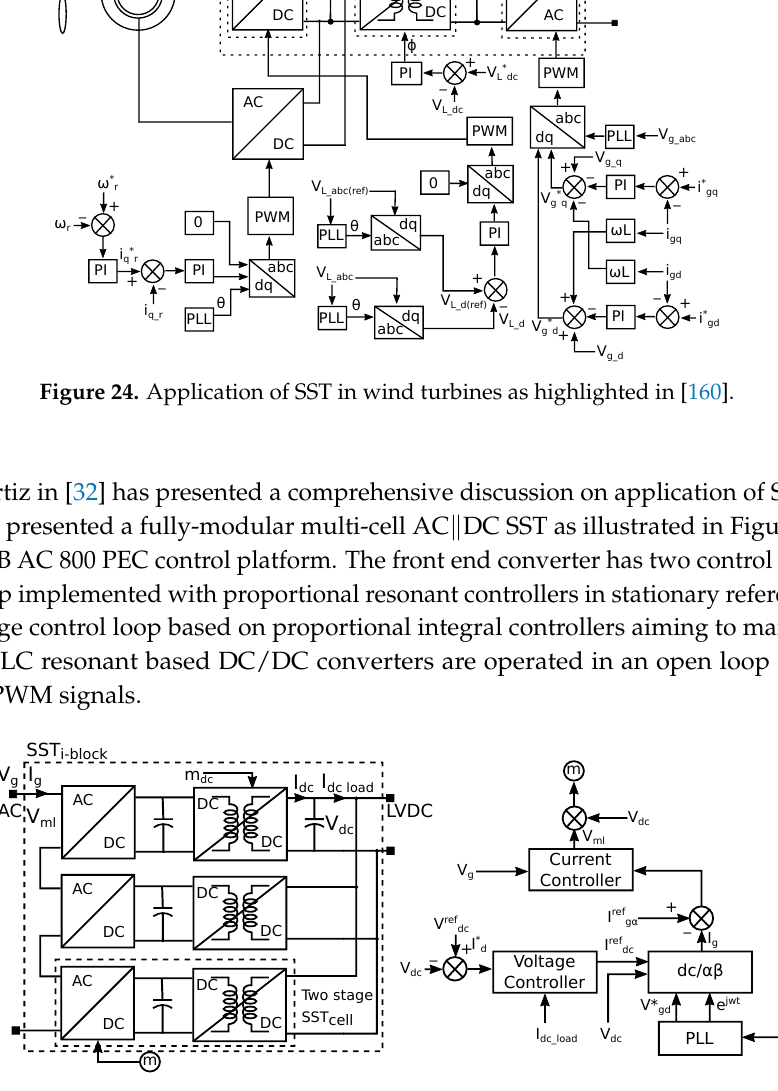
Figure 25. Application of SST in traction as illustrated in